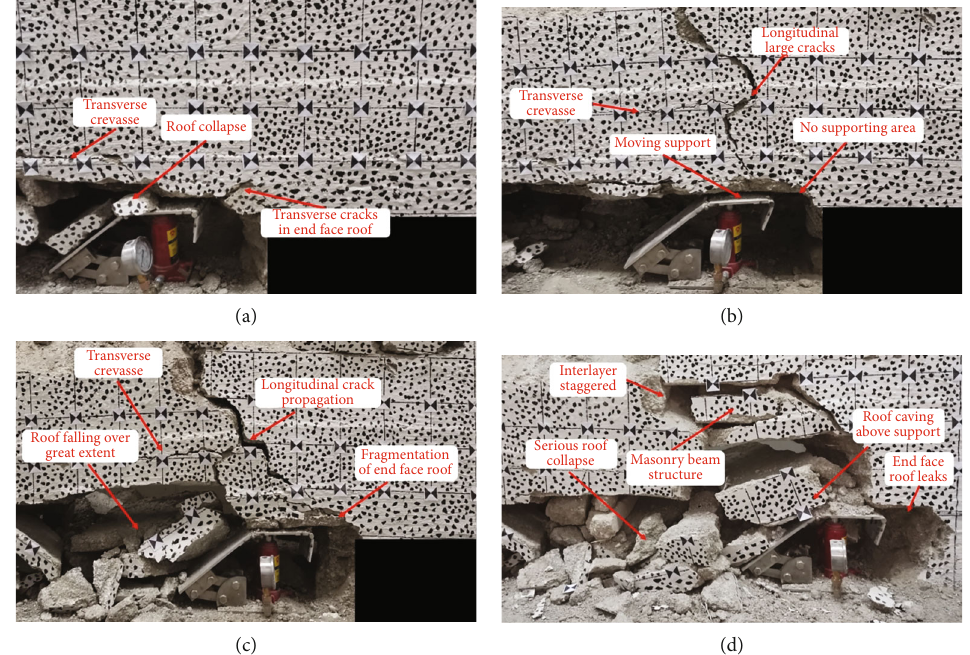
Figure 15: Evolution of support crushing under repeated